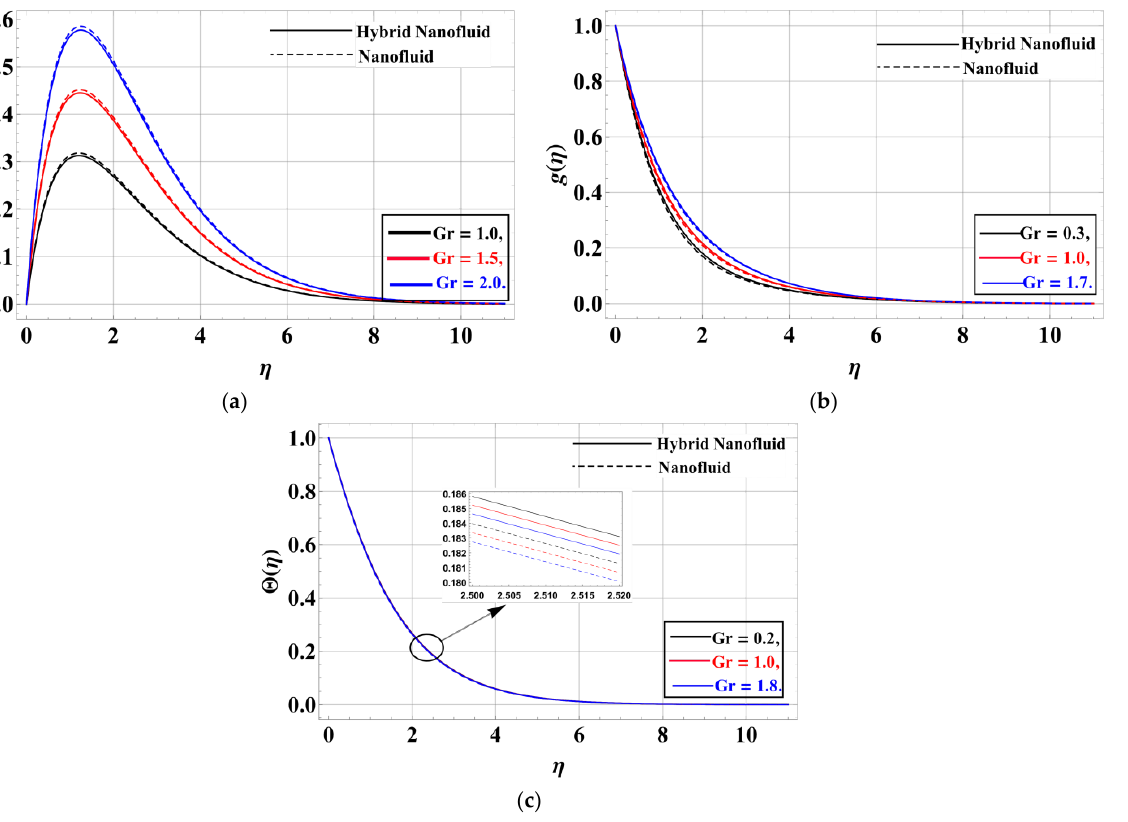
Figure 7. Variations in f (cid:48) ( η ) , g ( η ) & Θ ( η ) against Gr . ( a ) Variations in f (cid:48) ( η ) against Gr ( b ) Variations in g ( η ) against Gr ( c ) Variations Θ ( η ) against Gr